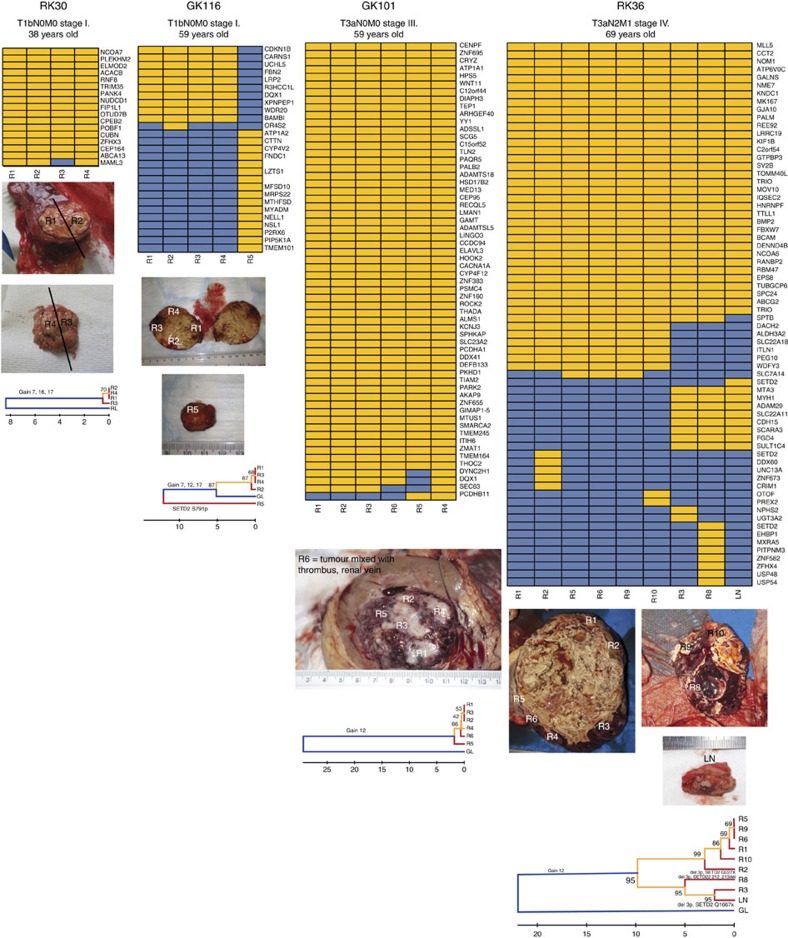
Regional distributions of non-synonymous somatic mutations in four pRCCs.For these M-seq cancers, the heat maps indicate the presence of a mutation (yellow) or its absence (blue) in each region. The non-M-seq sample GK116_2 is shown alongside GK116_1 for comparative purposes. Note that the SETD2 mutation p.Glu1667X in RK36 LN was identified in the combined call of all regions of this tumour, but not called by the M-seq pipeline; subsequent inspection showed the M-seq call to be a false negative (Supplementary Fig. 11). Each picture shows the regions of core biopsies and regions harvested at nephrectomy. Phylogenetic trees were generated by UPGMA from Ion Torrent M-seq SNV data. Branch and trunk lengths are proportional to the number of non-synonymous mutations acquired. No cancer showed a significant difference between the spectra of SNVs present on the trunk or branches (P>0.05, details not shown). Putative driver SCNAs and SNVs are shown on their respective branch. For clarity, sub-clonal SCNA gains are not shown for the highly branched tumour RK36; these involve chromosomes 7, 16 and 17, and are present in regions 5, 9, 1, 10, 3, LN and (apart from chr17) 8. The apparent discordancy between the SNV-based trees and SCNAs may reflect chance, genomic instability, recurrent mutations or reversion mutations.